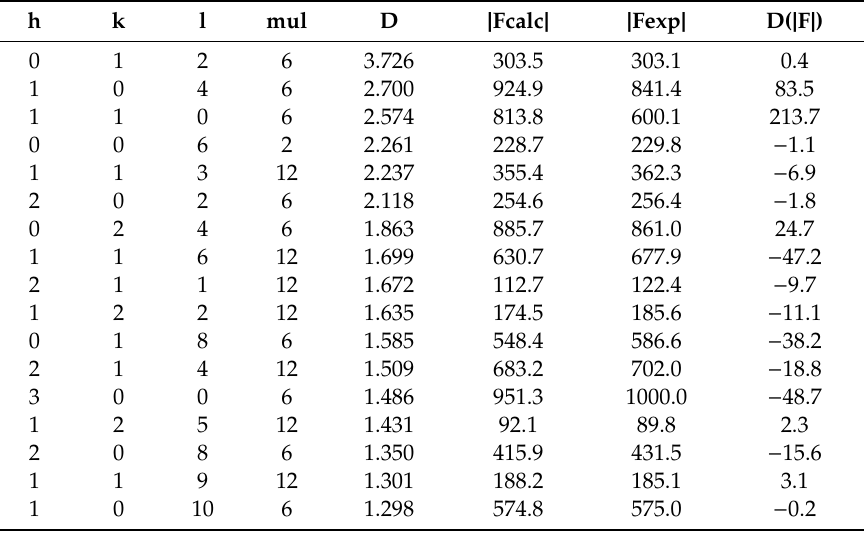
Figure 3. Integrated diffraction pattern of wangdaodeite and coexisting recrystallized ilmenite in a clast trapped in a shock-melt vein of Ries xenolith ZLN114. Black: Observed pattern. Red: Rietveld refined calculated pattern. Blue: Calculated refined pattern of wangdaodeite only. Green: Residual of fit. Blue and black tick marks indicate the Bragg angles of allowed reflections of wangdaodeite and ilmenite, respectively. Overlap of peaks of wangdaodeite with those of ilmenite and a structured background somewhat affect the quality of the refinement of wangdaodeite. However, the agreement of the R wP of the Rietveld refinement with R F indicates the absence of systematic errors in the structure refinement. The structured background is generated by the epoxy-resin that was used for impregnating the section. Table 4. List of observed and calculated factor moduli of wangdaodeite. The R F is